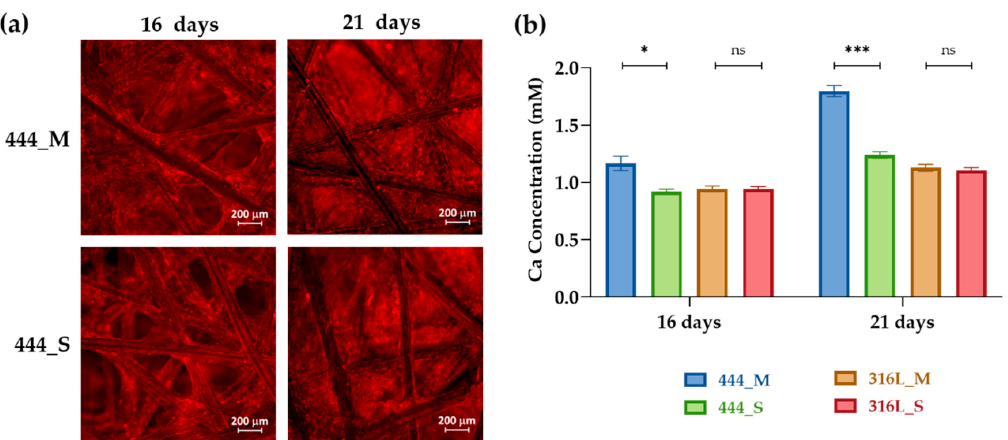
Figure 5. ( a ) Fluorescence imaging of calcium-rich deposits, stained with Alizarin red, of 444 actuated and non-actuated networks on days 16 and 21 of culture. Red areas indicate positive staining for calcium-rich deposits. ( b ) Calcium concentration on days 16 and 21 for all the tested groups measured from the released Alizarin red stain using a plate reader at 405 nm. Bars represent the mean ± standard error for each tested group ( n = 3). Statistical analysis was conducted by unpaired t test, * p < 0.05, *** p < 0.001, ns: no statistical significance.